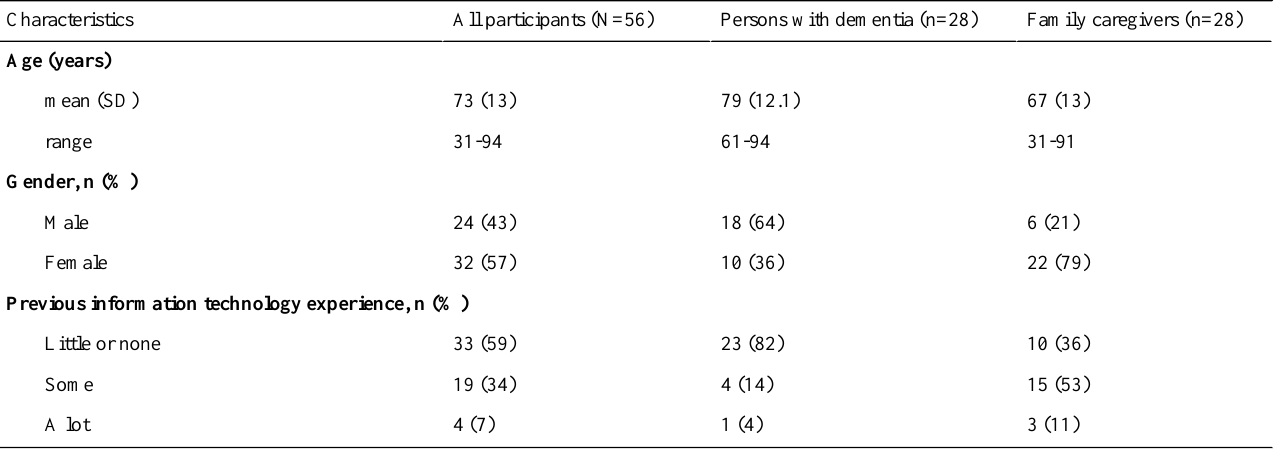
Table 1. Characteristics of participants in the InspireD study.